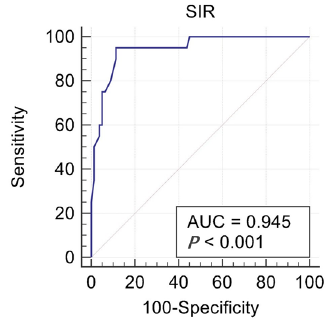
Figure 2. The ROC curve of the SIR